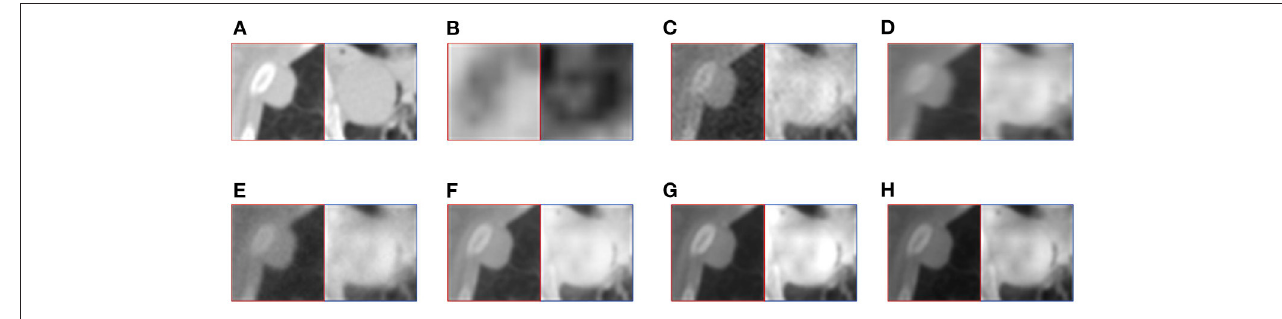
FIGURE 7 | The detail of fusion results of patient B. (A) CT; (B) PET; (C) AD; (D) GF; (E) PAPCNN; (F) MCFNET; (G) IFCNN; (H) OURS.